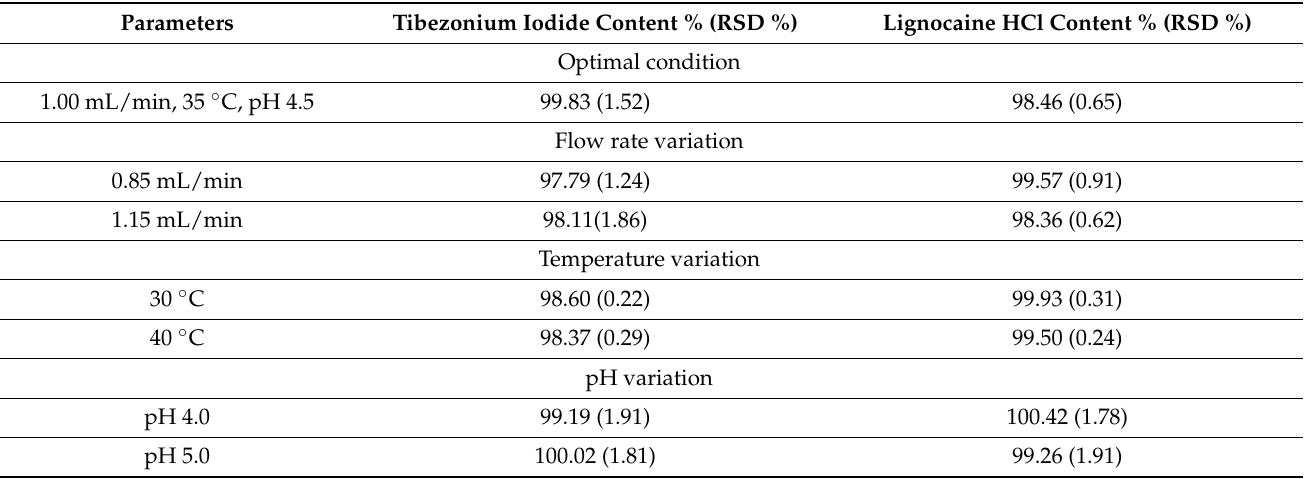
Table 4. Response of TBN and LGN indicating the robustness of the developed HPLC method.